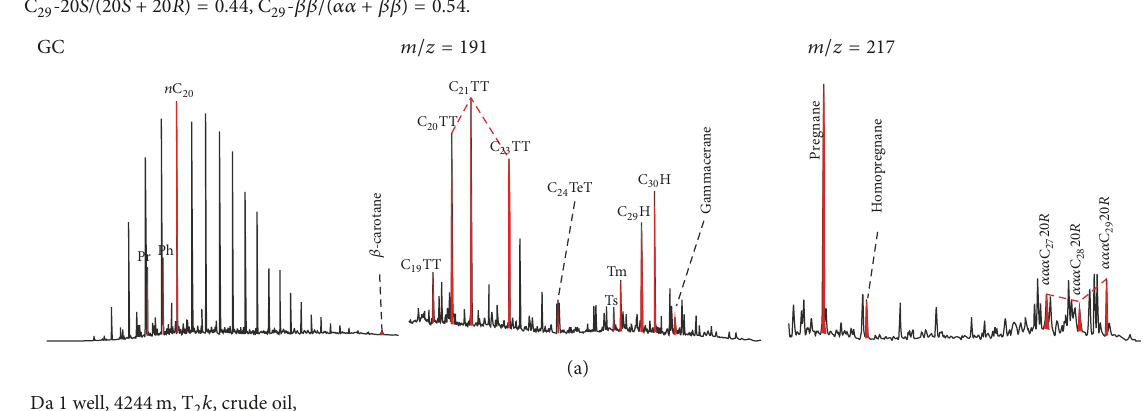
Da 1 well, 4244 m, T 2 k , crude oil, Saturate hydrocarbons = 88.87%, aromatic hydrocarbons = 4.43%, NSO = 3.46%, asphaltene = 1.48%, 훿 13 C = −27.75‰, Pr/Ph = 1.11,